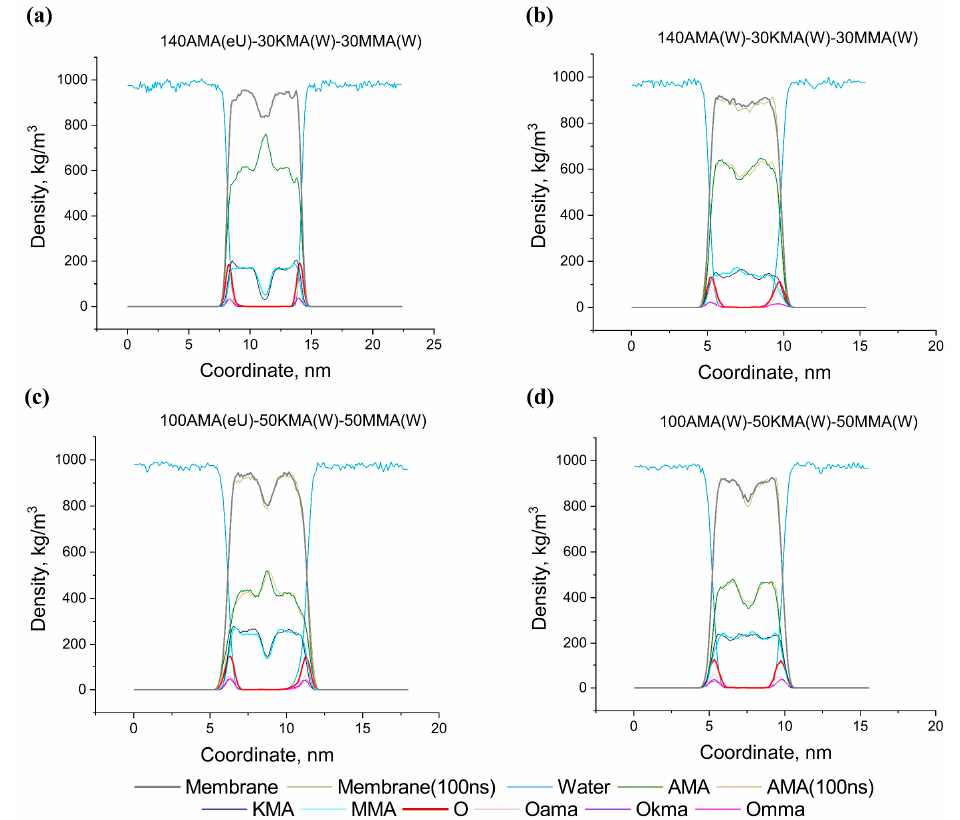
Figure 10. Density profiles for the multicomponent membranes at 100 and 300 ns.